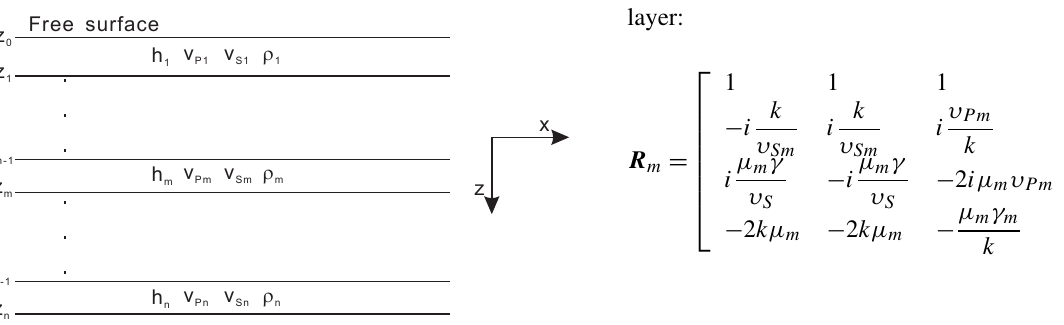
Figure 2. 1-D layered background model. The thickness, P wave velocity, S wave velocity, and density of each layer are